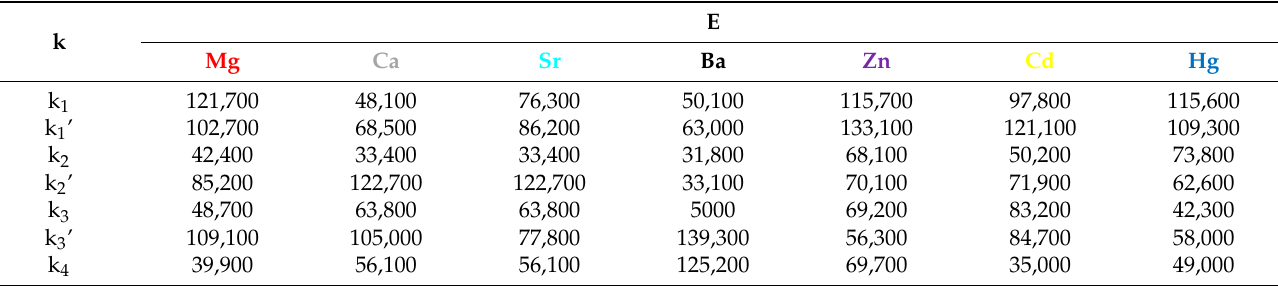
Table 3. Activation energy E in the Arrhenius equation k = Ae